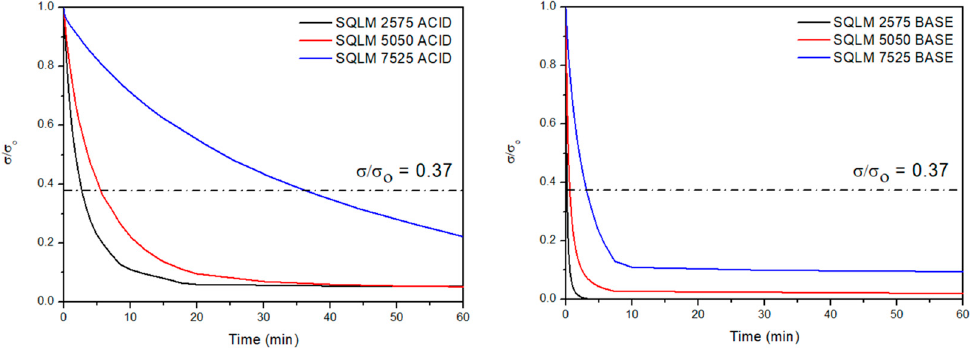
Figure 5. Normalized stress relaxation plots as a function of time for the di ff erent materials prepared with DBTDL ( left ) and with BGDBU ( right ) at 180